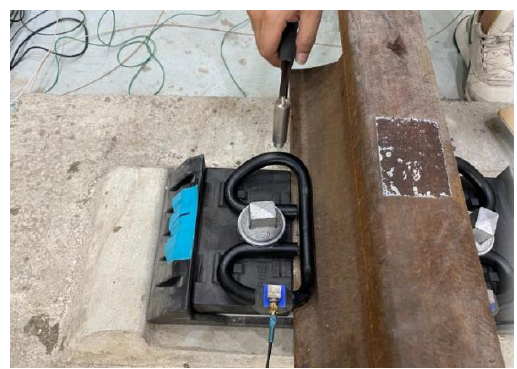
Figure 7. Modal test setup.